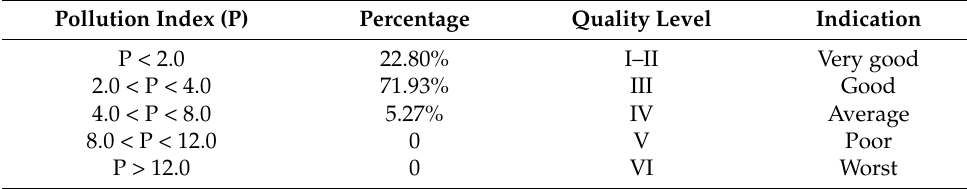
Table 5. Water quality test results in